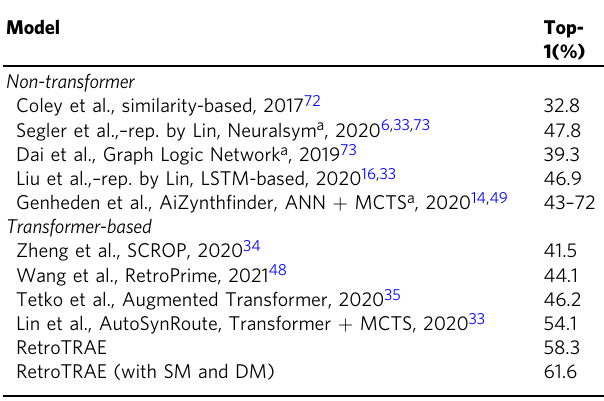
Table 3 A comparison of reported top-1 accuracies of retrosynthesis prediction models without additional reaction classes.